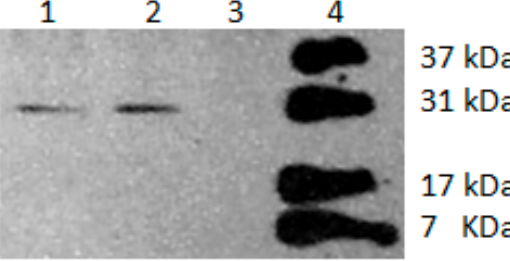
Figure 4. Western blot of FLAG-tagged Hc CDO probed with anti-FLAG antibody. Lane 1, C-terminus fusion; Lane 2, N-terminus fusion; Lane 3, no FLAG-tag control; Lane 4, protein MW standard. Size estimate determined by analysis of three independent blots = 25.7 kDa. Standard deviation was ± 2.4 kDa.